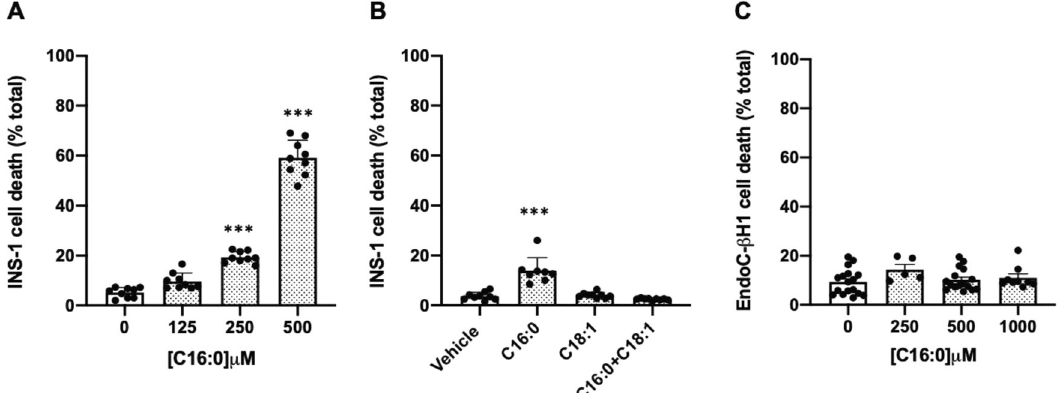
Fig. 1 Effects of palmitate (C16:0) on the viability of rodent and human β -cells. Rat INS-1E ( A ) and human EndoC- β H1 ( C ) cells were treated with vehicle (0 µM), 125 µM, 250 µM, 500 µM or 1000 µM C16:0 for 24 h or 72 h, respectively. INS-1E ( B ) cells were treated with vehicle (0 µM) or 250 µM C16:0, either alone or in combination with C18:1 (250 µM) for 24 h. Cell death was estimated using vital dye staining. Dots represent individual data points and the histograms represent mean values + SD ( N = 3). *** P < 0.001 relative to vehicle (0